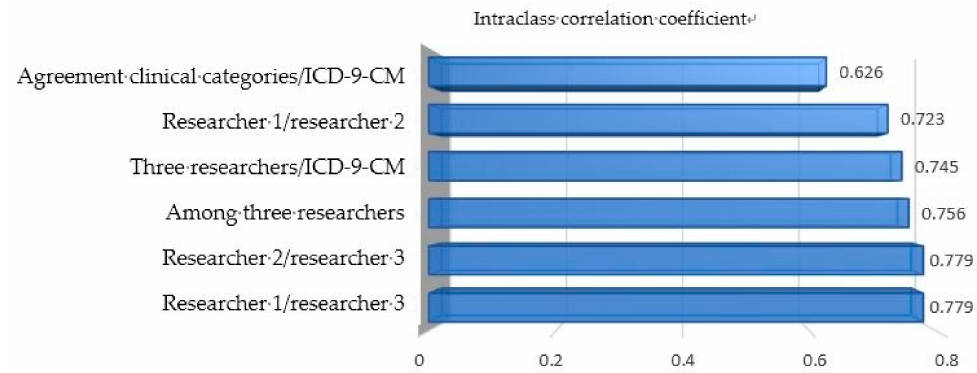
Figure 1. Intraclass correlation coe ffi cient between the number of polypathological patient (PP) categories identified through clinical identification and through automated identification with ICD-9-CM coding.